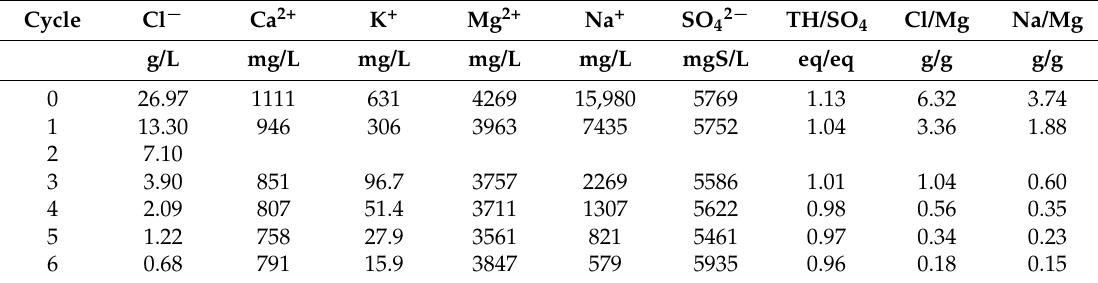
Table 3. Results of applying six DiaNF cycles on the retentate obtained from the NF step (DL membrane, ~60% RR) derived from the retentate produced in the dense UF step (GH membrane, 80% RR). External